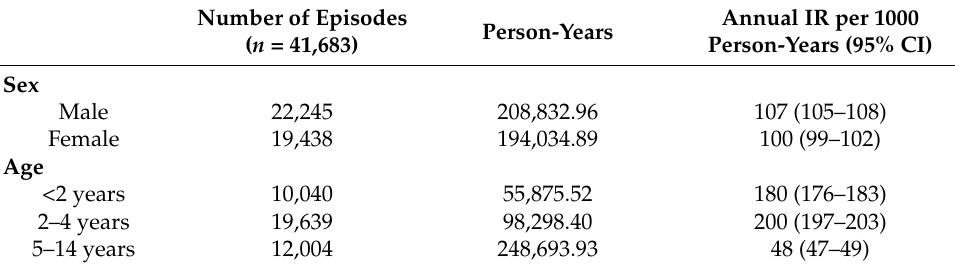
Table 2. Mean annual IRs of AOM by sex and age group.